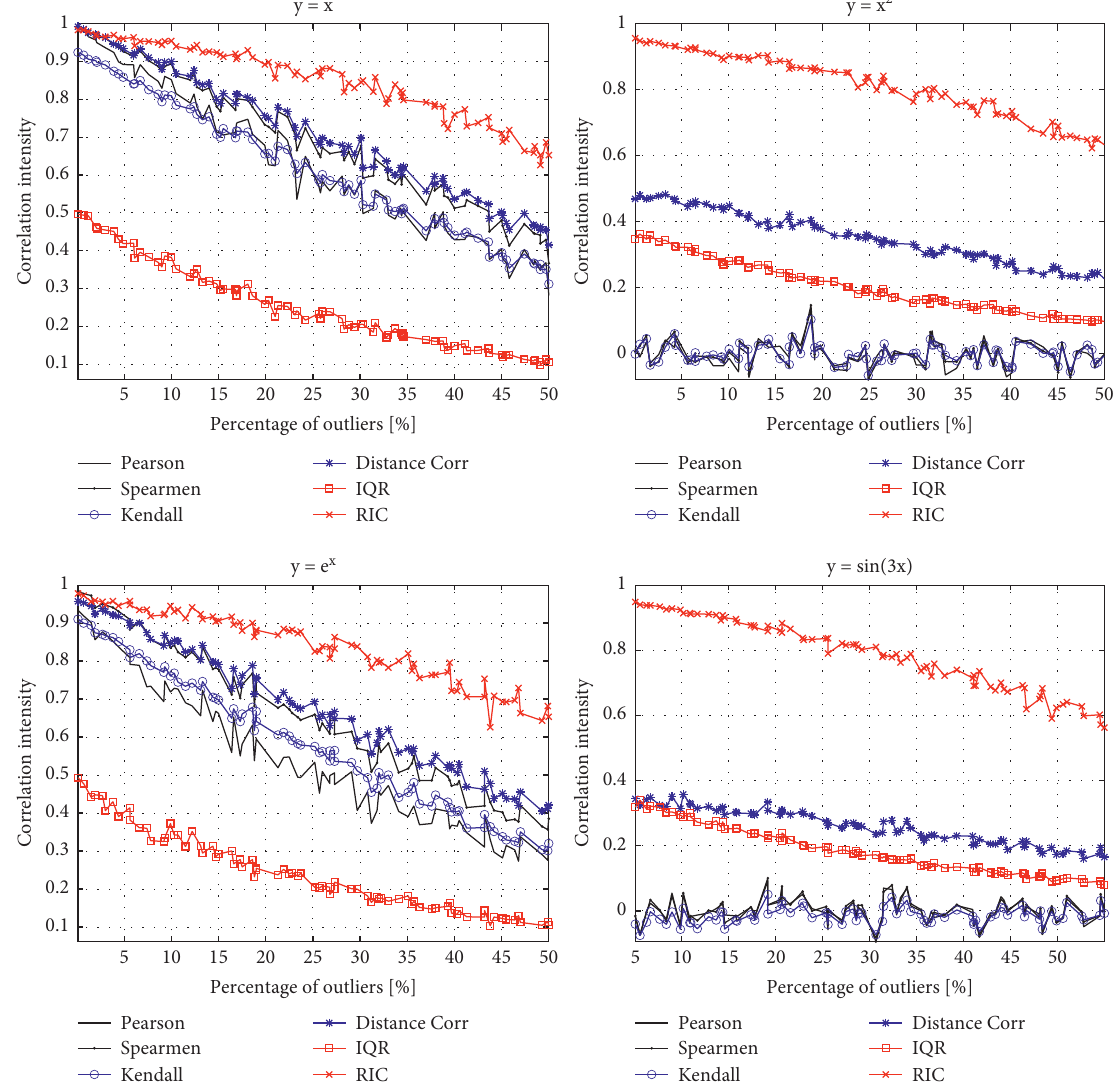
Figure 6: Robustness of RIC and other criteria against outliers. The x -axis reports the percentage of outliers generated randomly using a Gaussian distribution of large standard